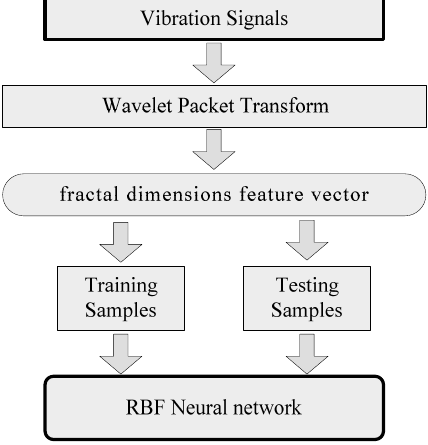
Fig. 5. The fault diagnosis procedure of rotating